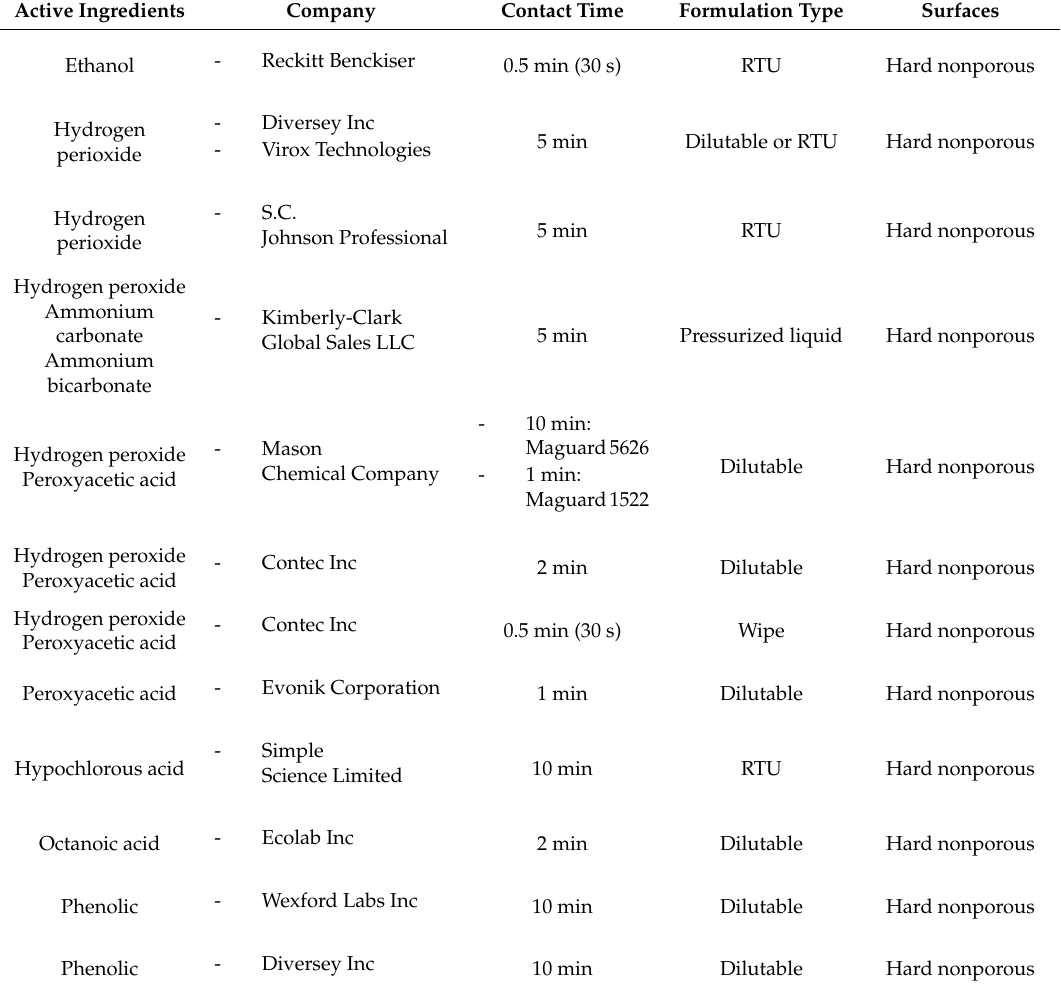
Table 2. List of Environmental Protection Agency-registered disinfectants against human coronavirus qualified under the EPA’s emerging viral pathogens program for healthcare settings